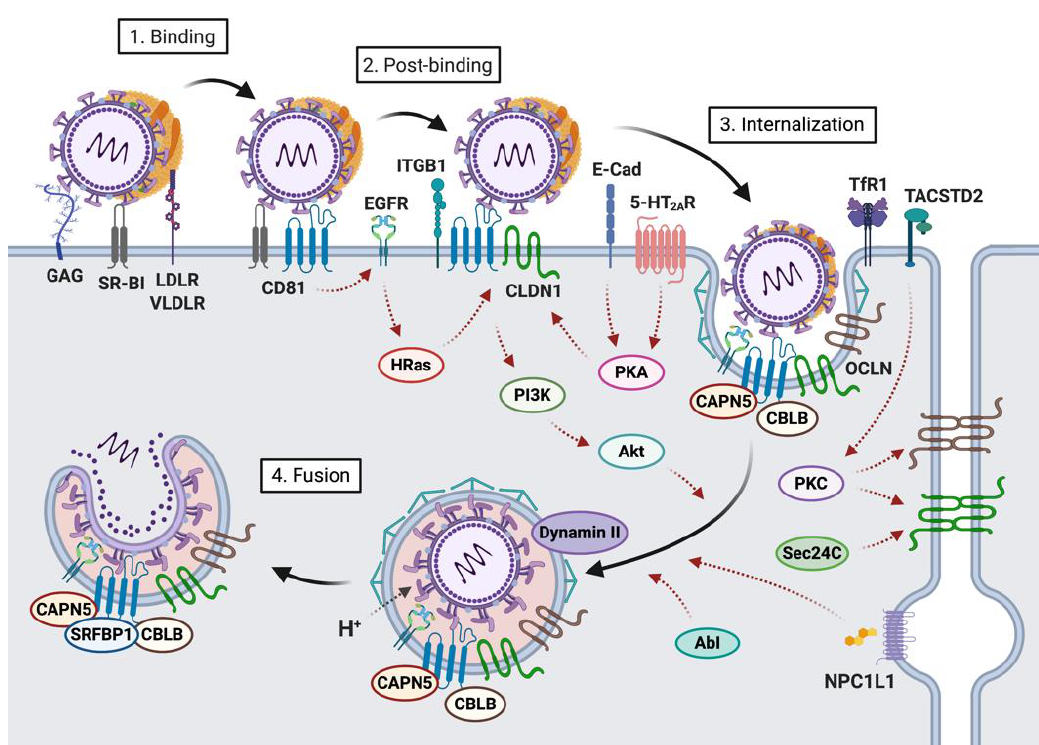
Figure 1. Schematic representation of the cell-free hepatitis C virus (HCV) entry pathway. This cartoon summarizes the host factors and sequence of events leading from initial viral attachment of lipo-viro particles (LVPs) to HCV internalization and release of the viral genome in the cytosol of hepatocytes. The initial binding step primarily involving the lipoprotein component of LVPs likely is a rather unspecific event, which results in the concentration of the virus at the basolateral membrane of hepatocytes and exposure of viral envelope glycoprotein domains that enable the virus to specifically interact with SR-BI, CD81, and CLDN1 (post-binding). The formation of an HCV co-receptor complex is essential for subsequent viral internalization via clathrin-mediated and dynamin-dependent endocytosis. This process is highly regulated by various kinases. Endocytotic vesicles ultimately mature into acidic endosomes, thus promoting low pH-dependent HCV fusion.